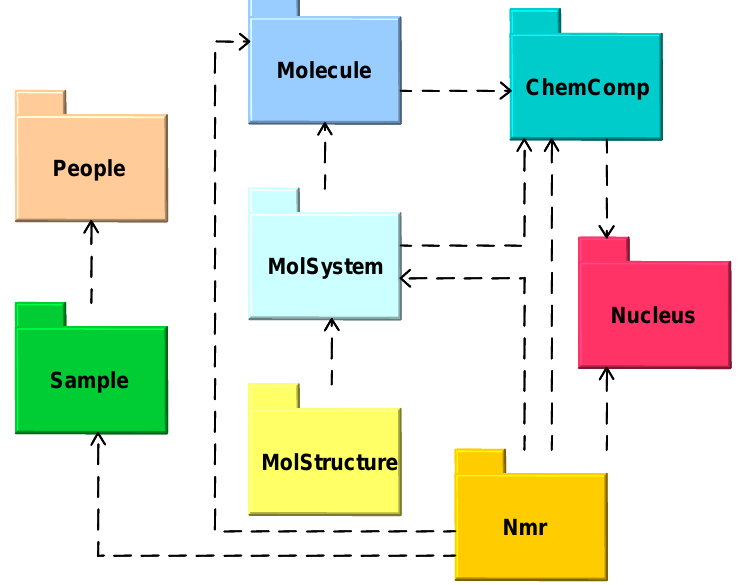
Supplementary Figure 4: Examples of packages from the CCPN data standard. Packages are used to partition both the model description, the API implementation code, and the data storage for file implementations. MolStructure contains coordinates, MolSystem atomic level description of molecular complexes, Molecule sequences, and ChemComp residue templates. Dotted arrows show dependency relationships; e.g. MolStructure depends on MolSystem and on ChemComp (not